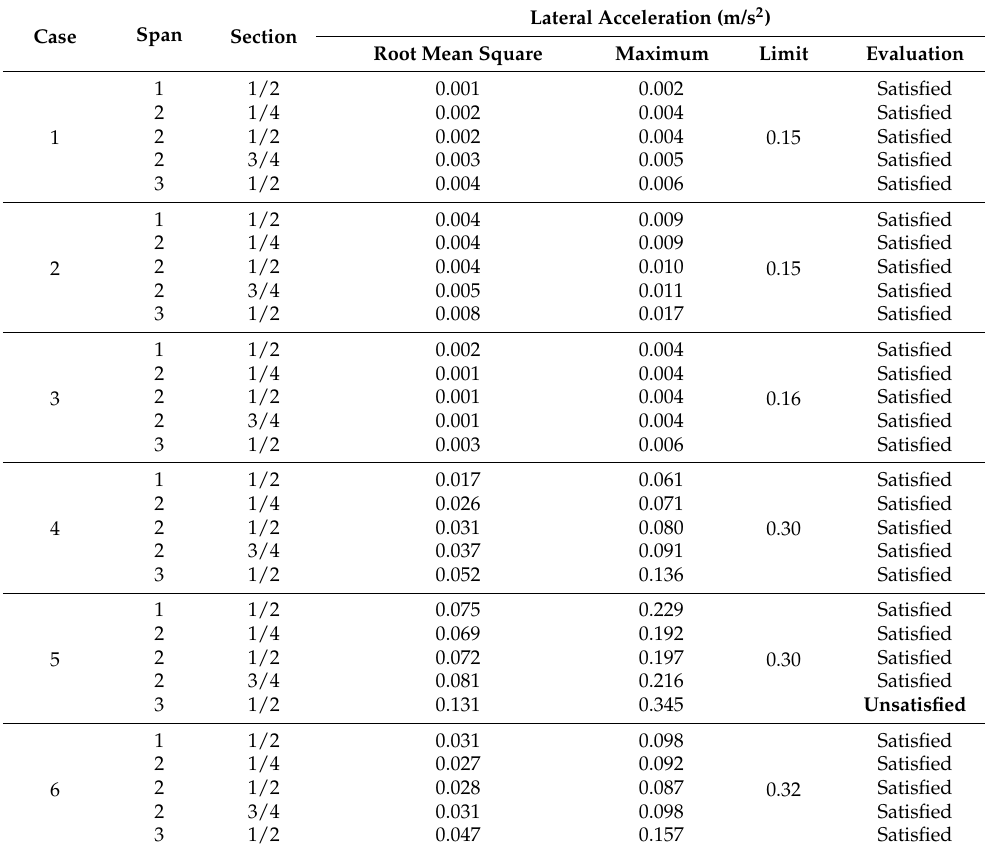
Table 3. Simulation results of the lateral accelerations of the bridge under pedestrian loads.